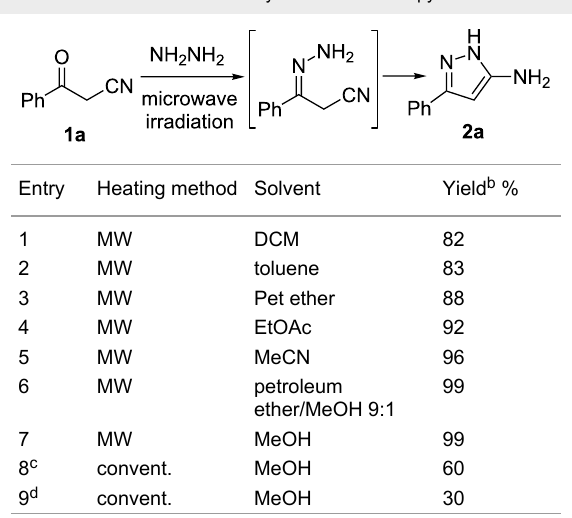
and isolation of the intermediate 5-aminopyrazoles followed by their reaction with an appropriate β -dicarbonyl compound [1-4,19-29]. A very recent and excellent review by Aggarwal et al. covers the use and versatility of 5-aminopyrazoles in the synthesis of a range of pyrazoloazines [30].